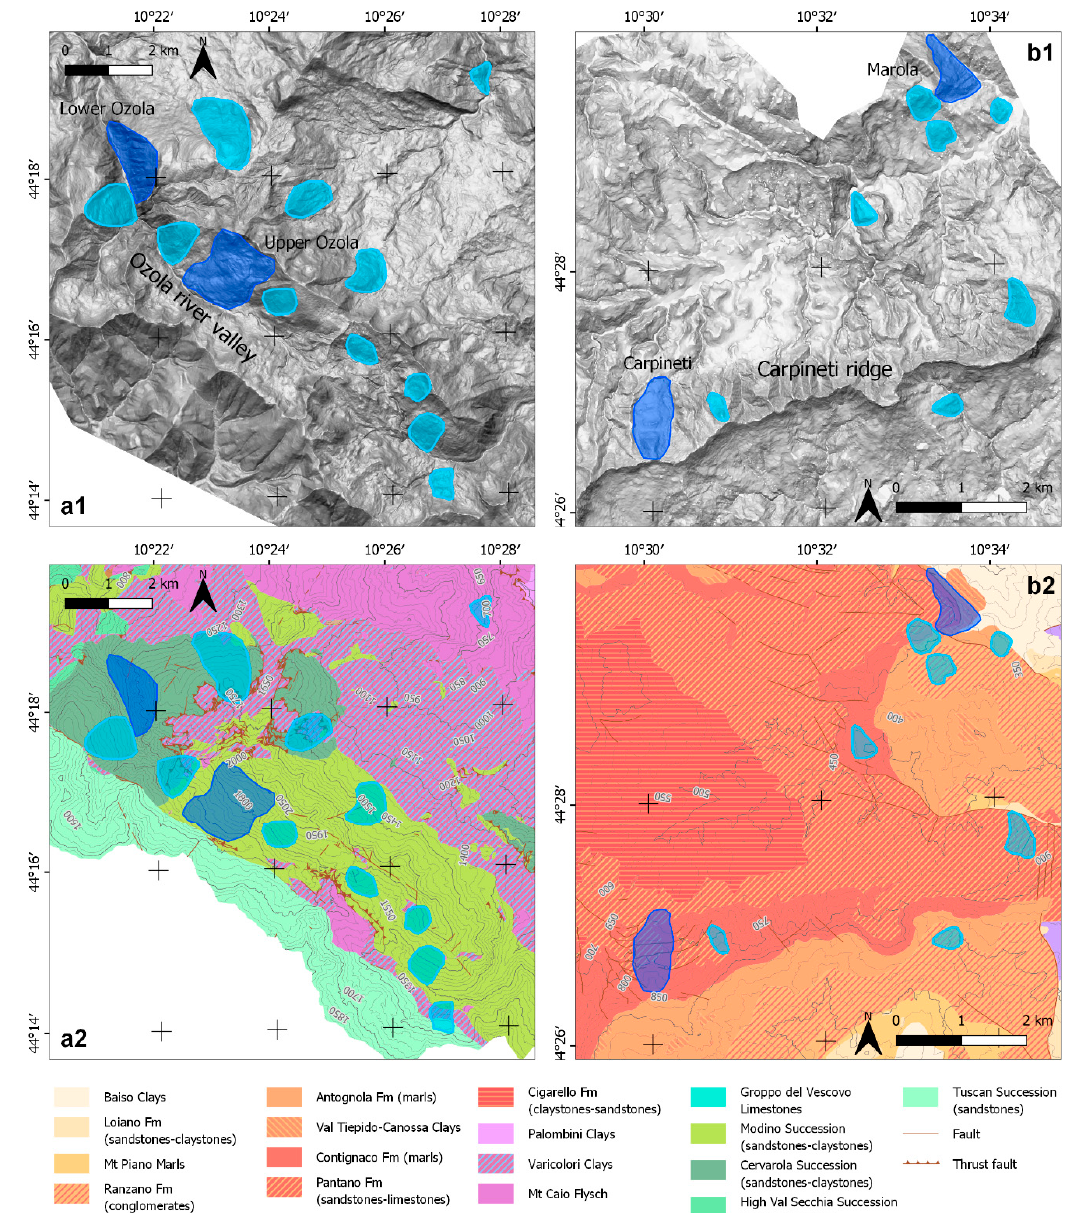
Figure 3. Inventory of the identified DSGSDs for the Ozola river valley and Carpineti ridge study areas. DSGSDs are shown in light blue, whilst those landforms investigated in detail are in blue. In ( a1 ) and ( b1 ), the background is the hill shade model produced from the digital terrain model (DTM) [86], in ( a2 ) and ( b2 ) the geological map at scale 1:50,000 [87].